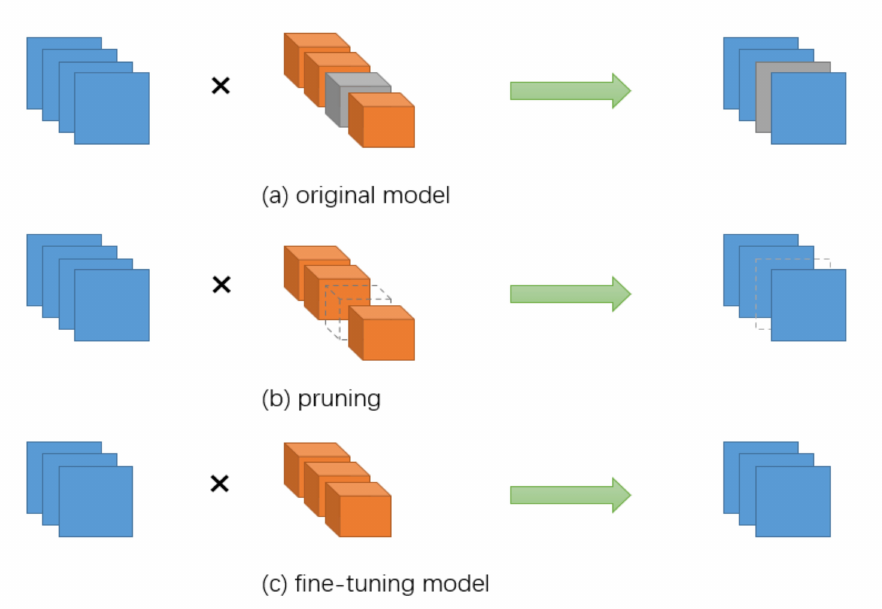
Figure 1. Schematic diagram of model